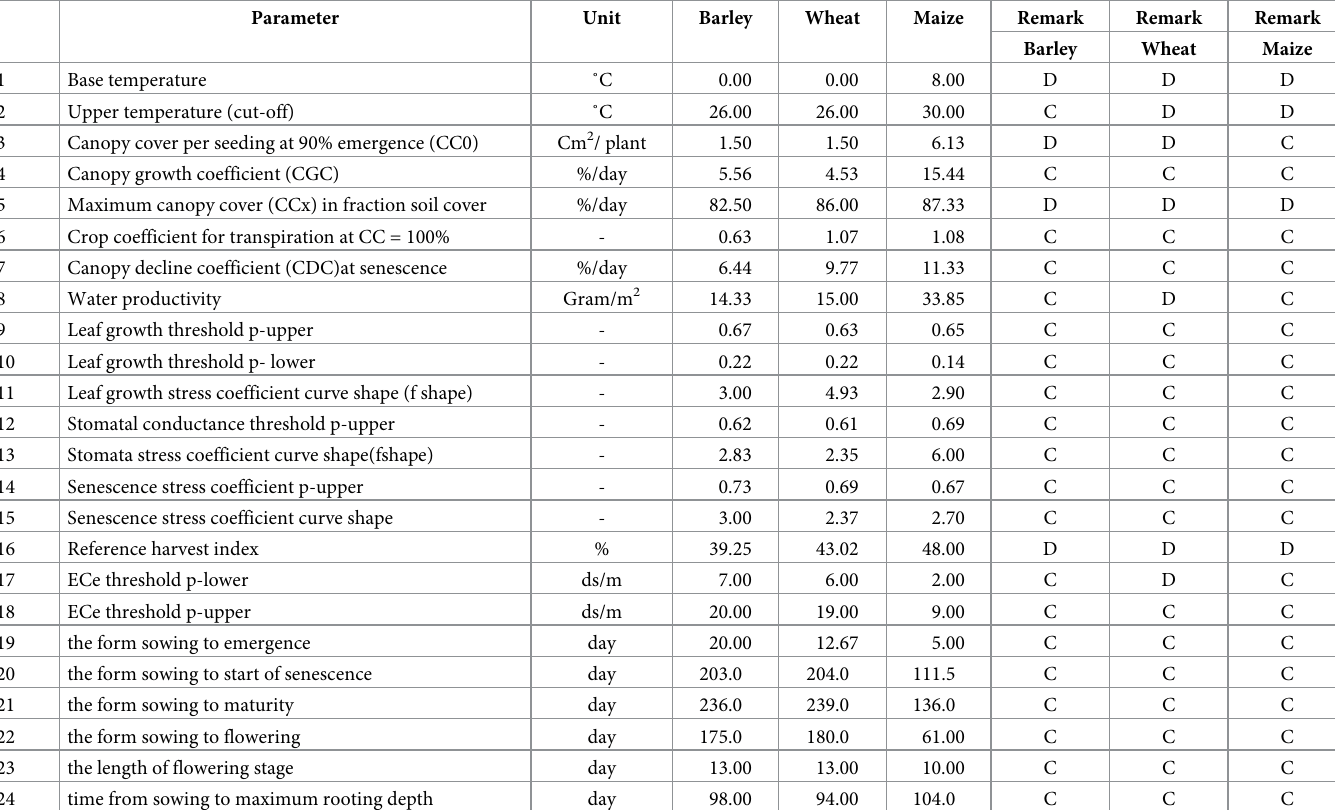
Table 4. Summary of parameters used in AquaCrop